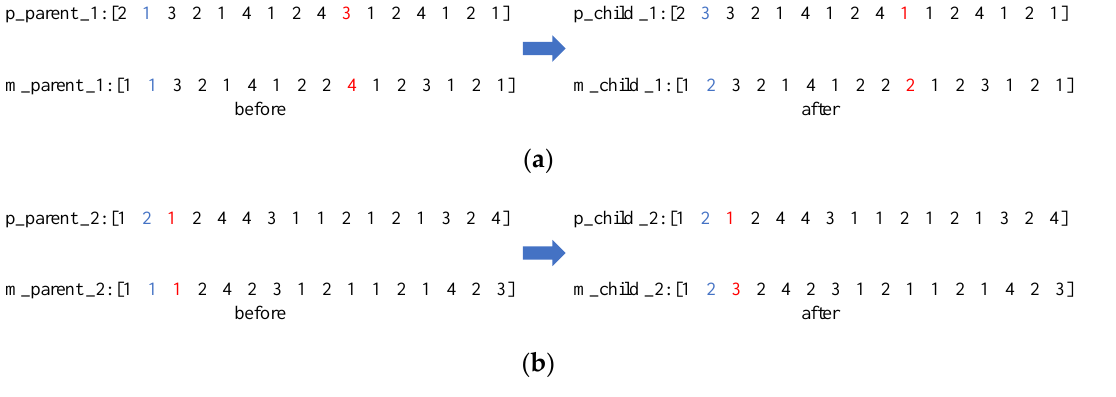
Figure 14. Mutation: ( a ) Crossover of the process chromosome; ( b ) Crossover of the machine tool chromosome.